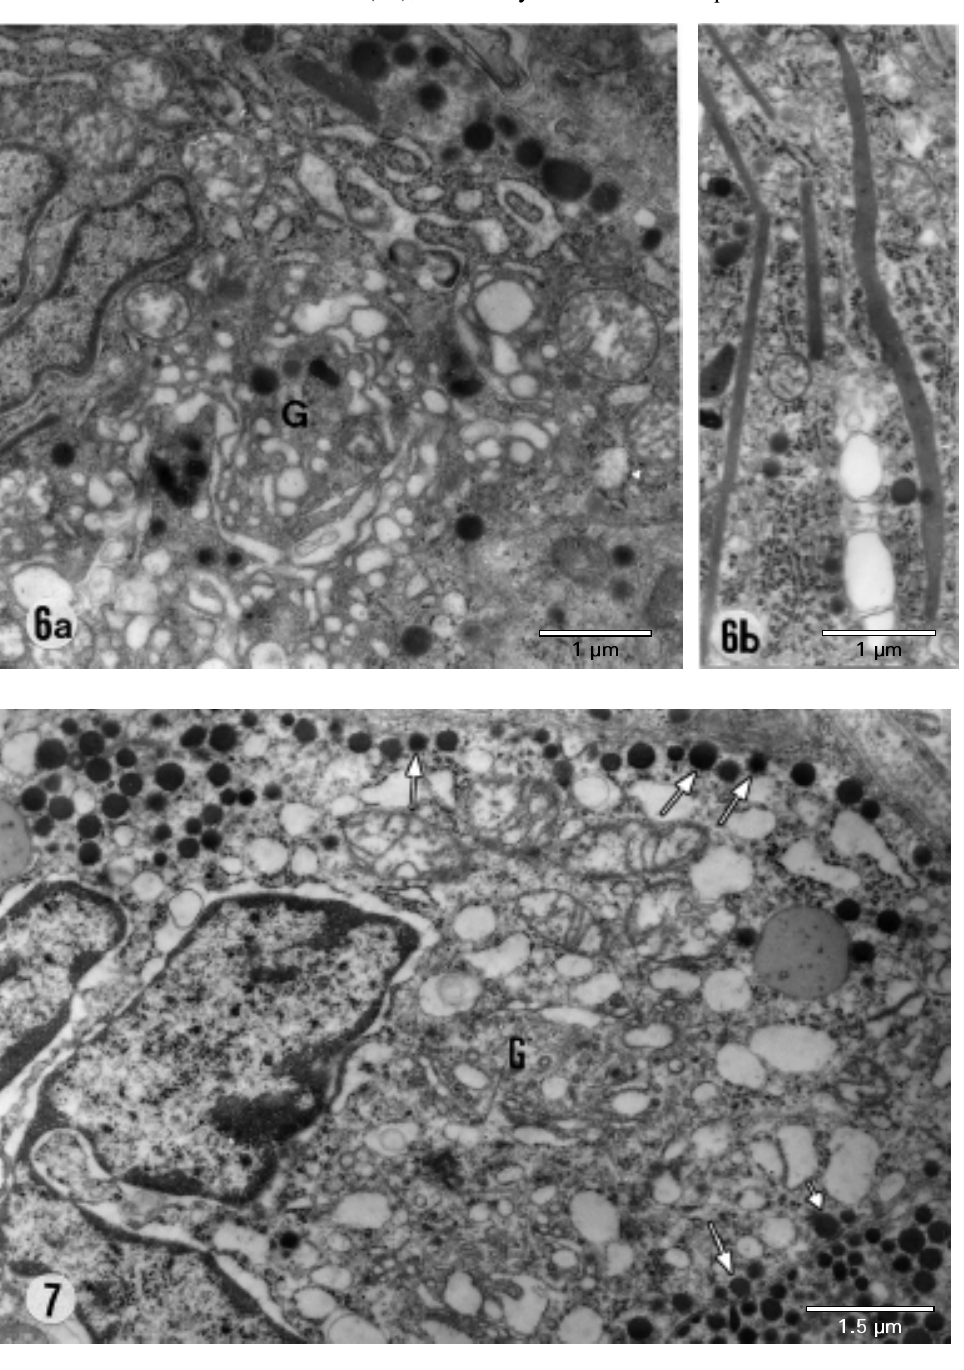
Figure 6 - Electron micrographs of a PRL cell from an undernour- ished animal exhibiting a hyper- trophic Golgi complex (G) with immature secretory material (a). Peripheral granules and irregular rough endoplasmic reticulum are seen in the right upper corner (18,000X); b , long cytoplasmic crystalloids (18,000X).